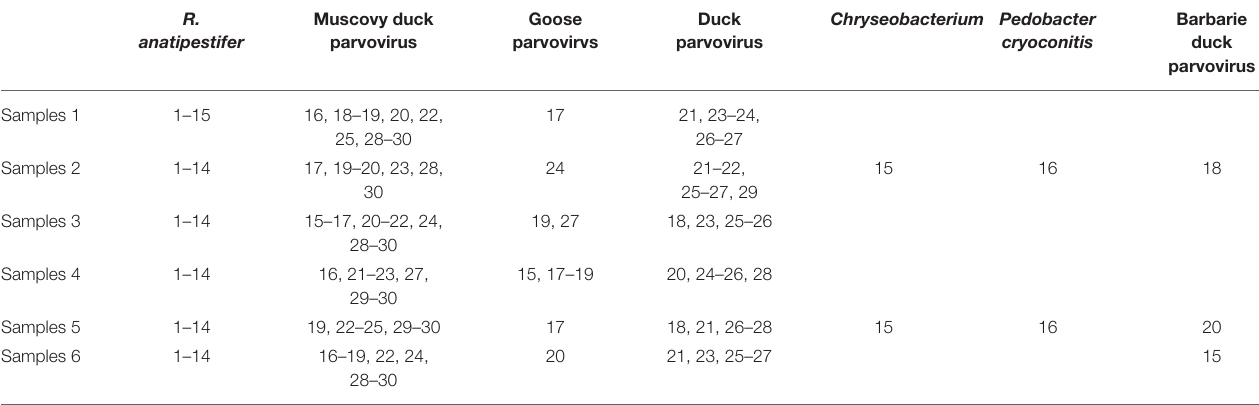
TABLE 1 | Blast results after high-throughput sequencing of six spotted spleen samples.